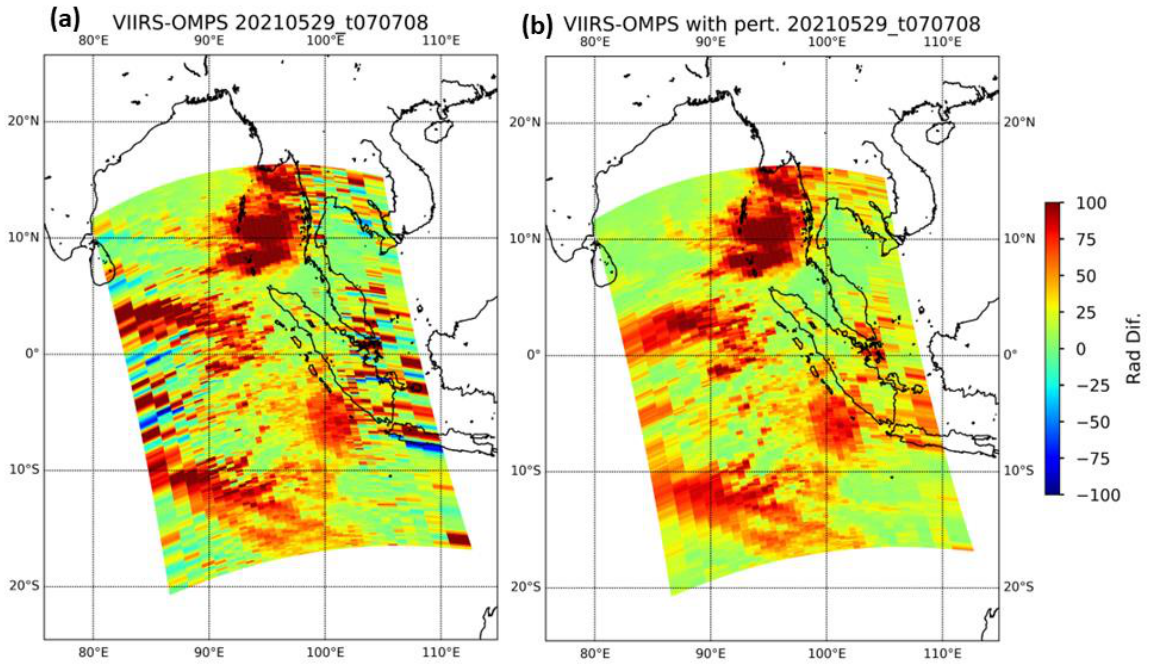
Figure 4. Radiance difference image between real and VIIRS-collocated OMPS-NM radiances: ( a ) based on the original OMPS geolocation fields and ( b ) the ones with perturbation that perfectly are aligned with VIIRS. The radiance unit is W/(cm 3 Sr).